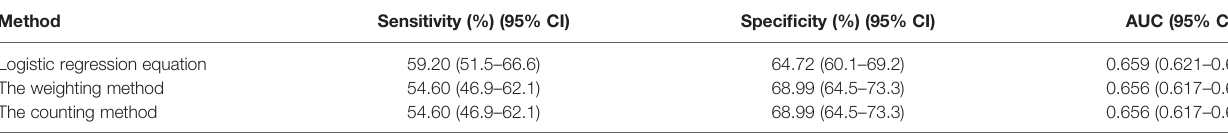
TABLE 6 | Comparison of the logistic regression equation, the weighting, and the counting methods in predicting the axillary LN metastasis.